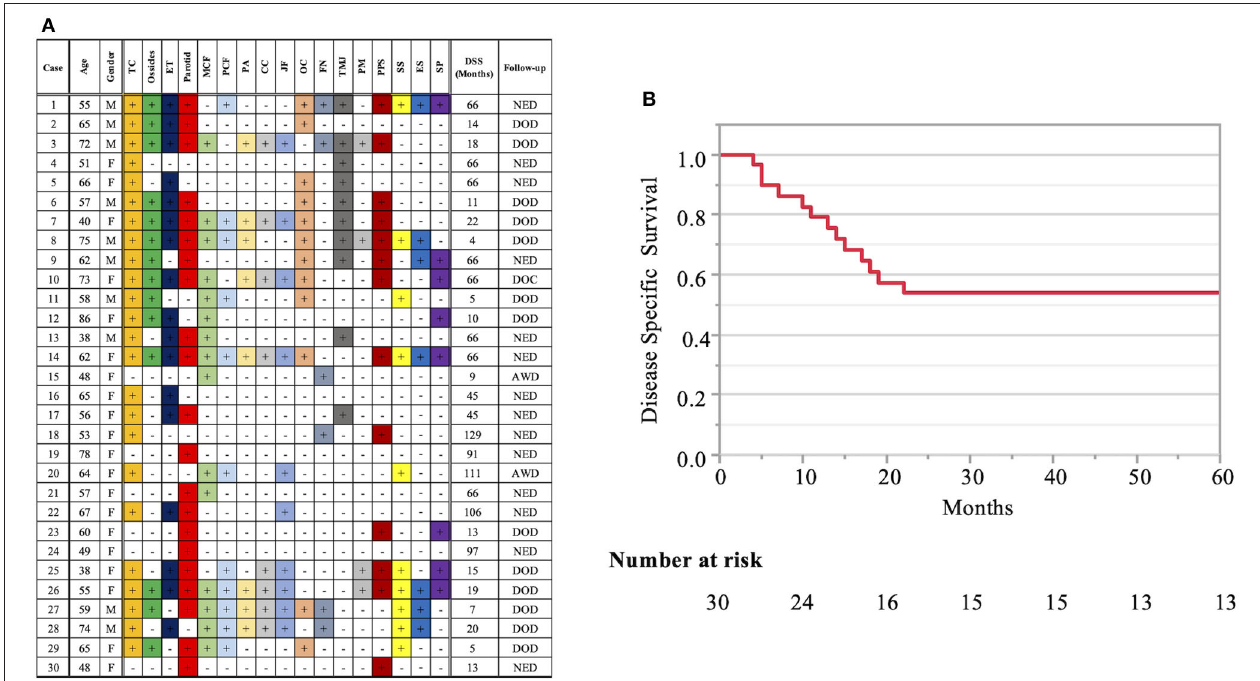
FIGURE 2 | Detailed information on the invaded structures (17 landmarks) (A) and disease-specific 5-years survival curve in all T4 cases (B) . Anatomical factors examined include the tympanic cavity (TC), ossicles (the destruction of the ossicles in the middle ear), eustachian tube (ET; the infiltration of the tympanic orifice of the eustachian tube), parotid gland, middle and posterior cranial fossae (MCF and PCF), petrous apex (PA), carotid canal (CC), jugular foramen (fossa) (JF), otic capsule (OC), facial nerve (FN; facial nerve paralysis), temporomandibular joint (TMJ), pterygoid muscle (PM), parapharyngeal space (PPS), sigmoid sinus (SS), endolymphatic sac (ES), and styloid process (SP).